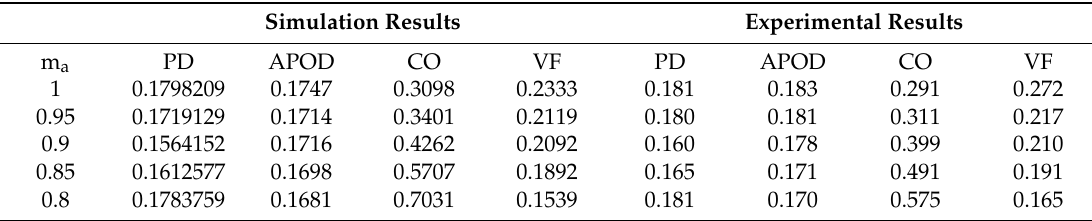
Table 4. %Distortion factor for different modulation